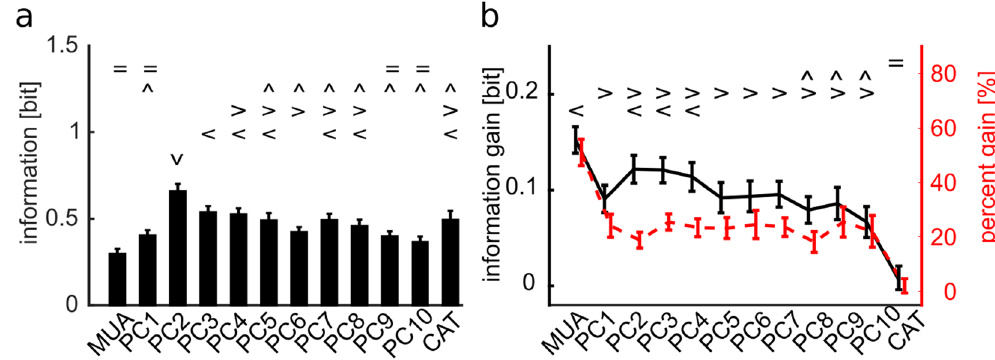
Figure 3. Stimuli information carried by R changes according to different post-stimulus network responses. ( a ) Mean and SEM across experiments of I ( S ; R ) summed over 100 ms post-stimulus time interval for different network responses R . Symbols { = ^ > < v} mark data groups that have similar means (Tukey’s HSD, p < 0.05), see Supplementary Information, Different symbols indicate not significantly different means for information I ( S ; R )(F(12, 1287) = 30.45, p = 10 − 62 , one-way between subject ANOVA followed by Tukey’s HSD multiple comparison test). PC2 response carries the highest stimulus information. ( b ) Mean and SEM across experiments of information gain (black line) and percentage information gain (red dashed line) for different network responses. Symbols { < > ^ = } mark data groups that have similar means (Tukey’s HSD, p < 0.05), see Supplementary Information. Black symbols indicate not significantly different means for information gain (F(12, 1287) = 14.99, p = 10 − 30 , one-way between subject ANOVA followed by Tukey’s HSD multiple comparison test). Differences between response measures are not significant for the percentage information gain (F(12, 1287) = 1.5, p =